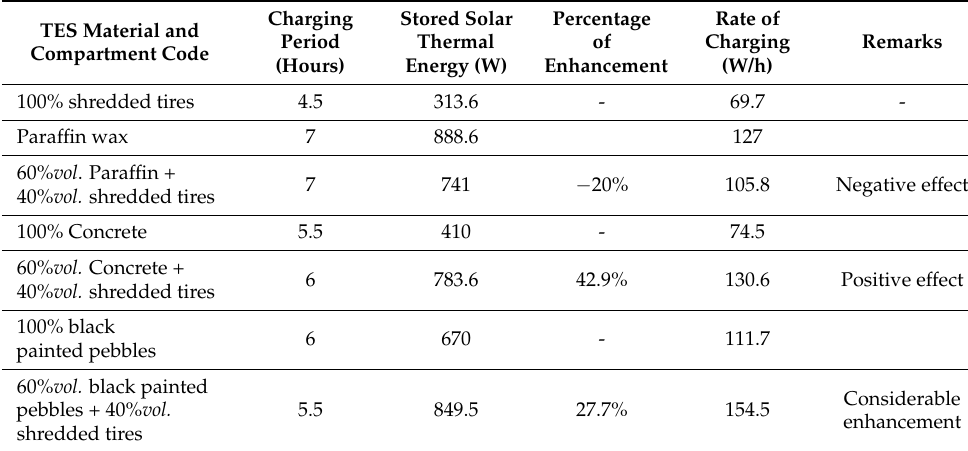
Table 5. The charging behavior of the tested TES